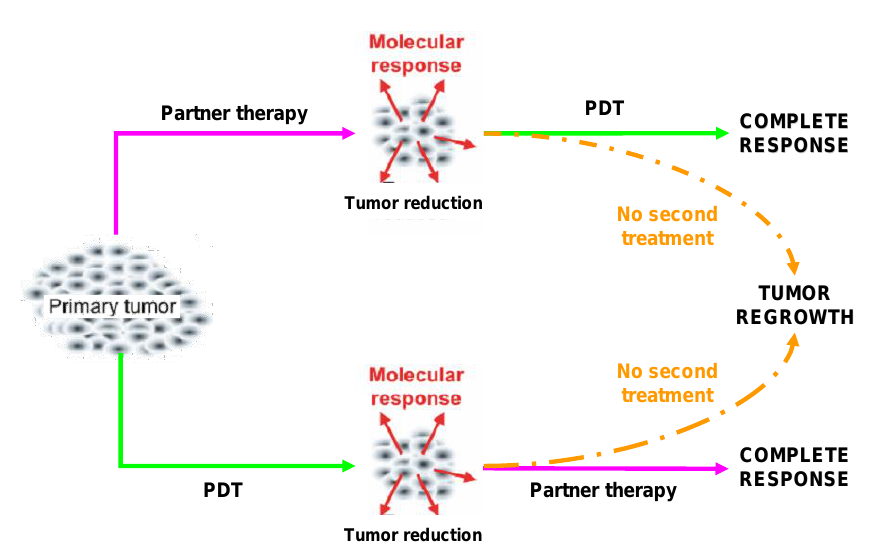
Figure 2. Combined therapy